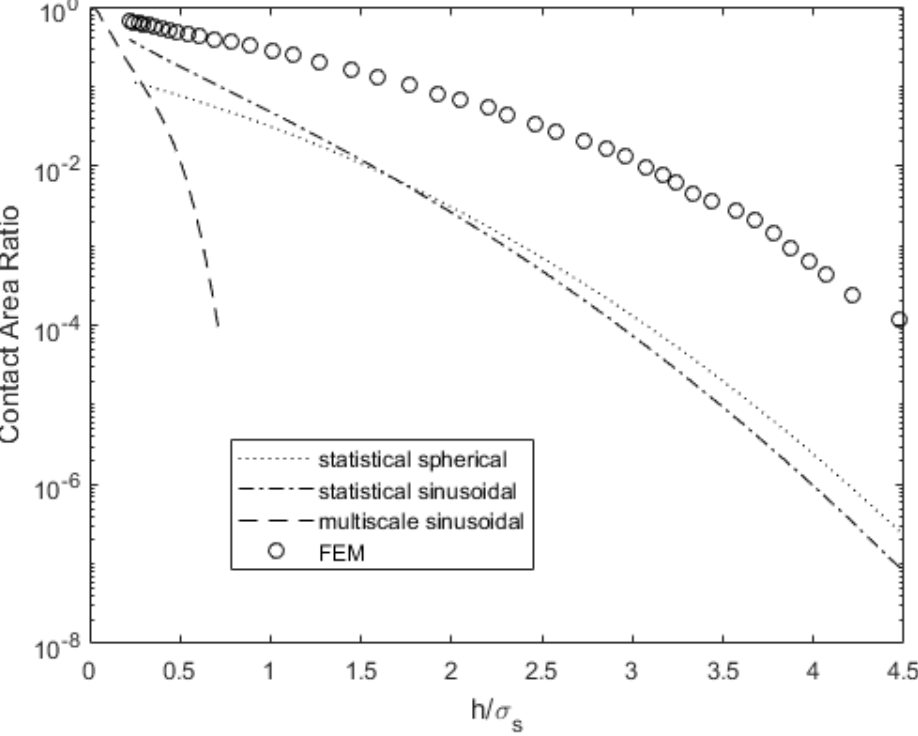
Figure 6. Contact area comparison for varying surface separation for surface 4L.